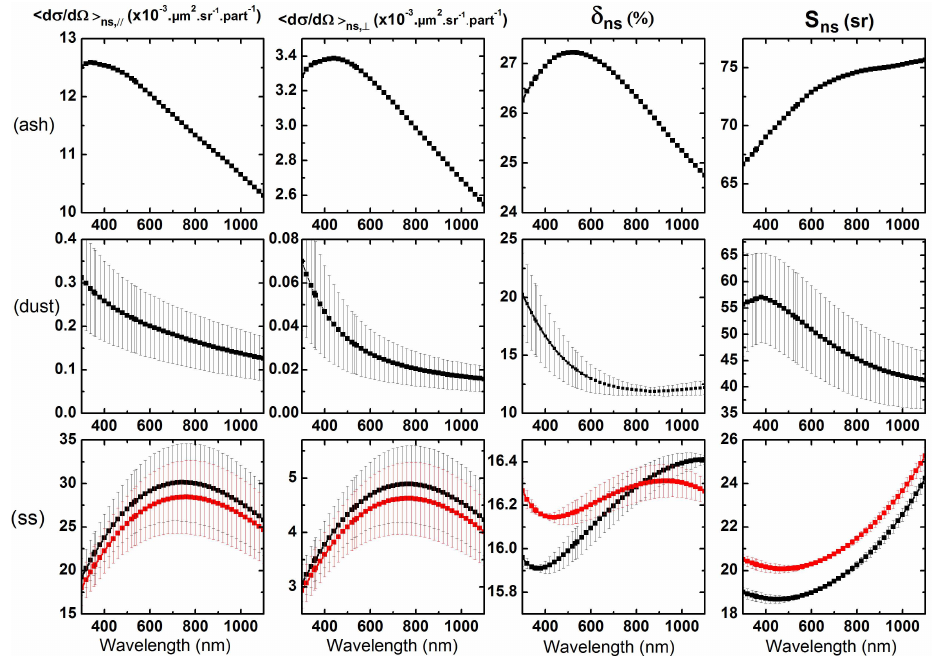
Fig. 4. Ns-particle backscattering coefficients, particle depolarization ratios δ ns and lidar ratios S ns as a function of the λ wavelength, for each ns-particles type: volcanic ash, desert dust and sea salt (ss). The plotted error bars correspond to the size and shape sensitivity study performed in Sect. 3.4. For ss-particles, two curves are represented, one for each refractive index given in Table 2. Table 3. Results of the T-matrix simulations: depolarization ratios δ ns averaged over the corresponding PSD, cross-polarized ˚ A ngstr ¨